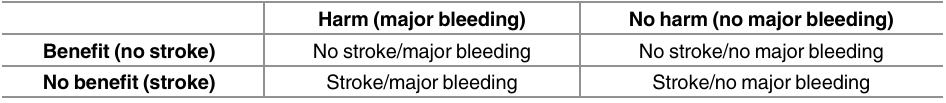
Table 1. Warfarin ’ s combined benefit and harm